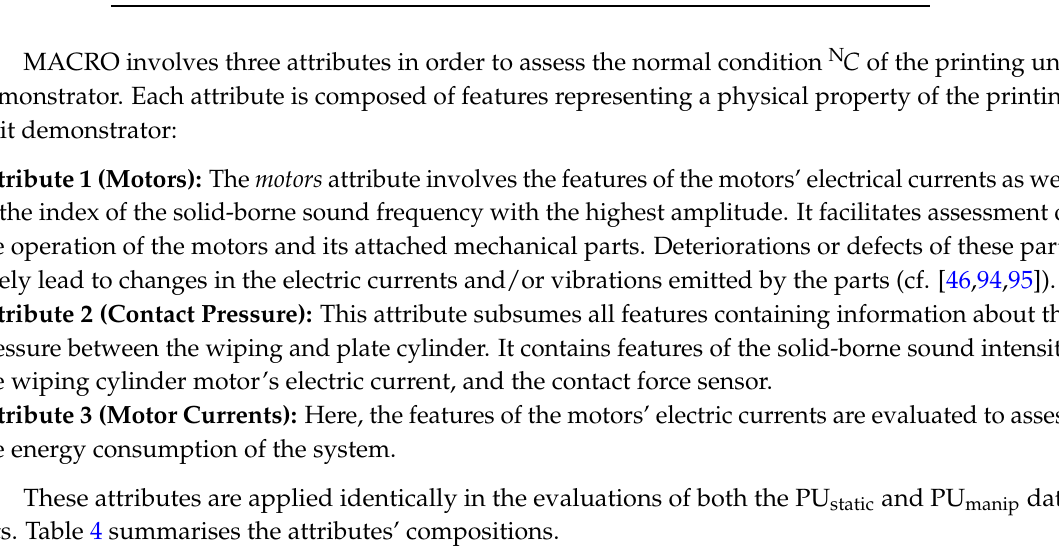
Table 4. MACRO attribute compositions for the printing unit demonstrator